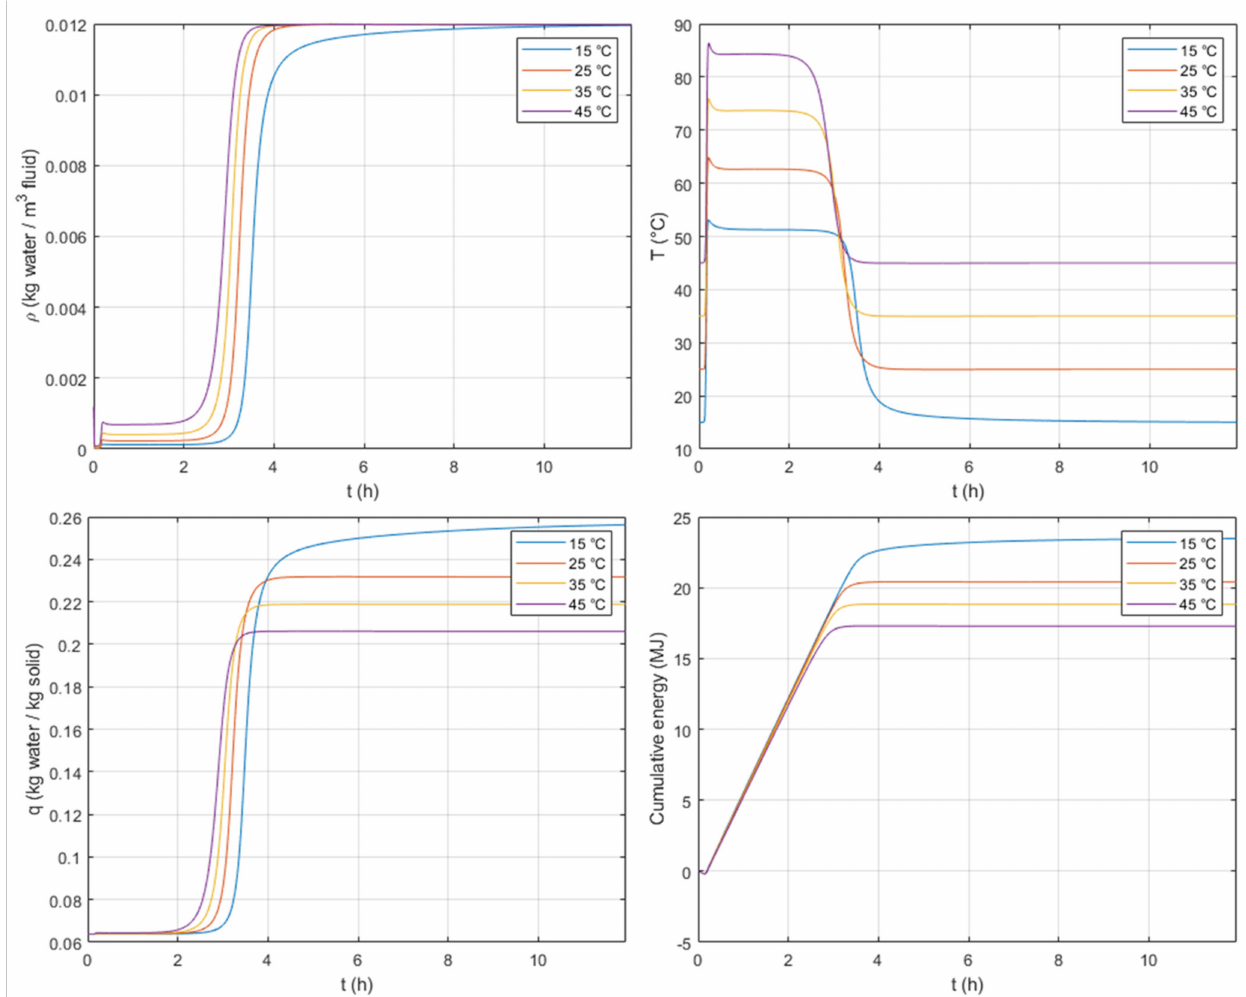
Figure 9. Parametric analysis of the inlet fluid temperature and study of the evolution with time of water fluid concentration, fluid temperature, water adsorbed concentration, and cumulated heat at the column